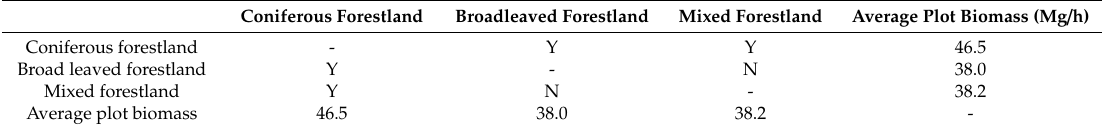
Table 7. Tukey’s Honestly Significant Di ff erences (Tukey’s HSD) test for comparing average